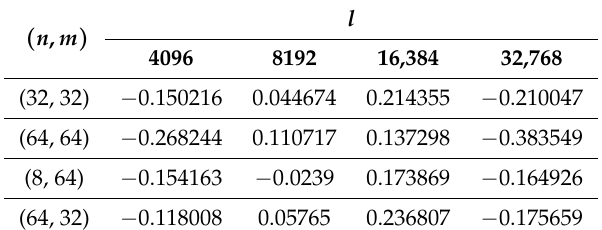
Table 4. Observed (cid:98) E ( Z T | H 0 ) values for each selected n , m , l